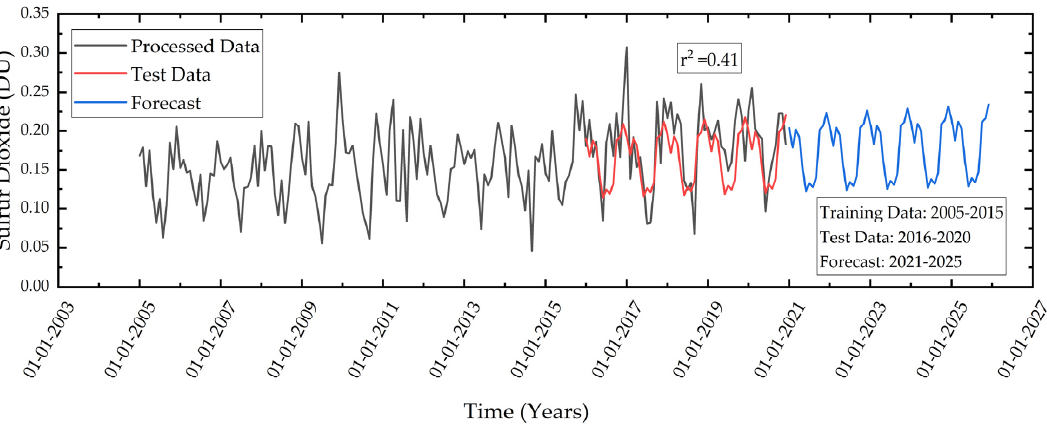
Figure 7. Temporal variations of monthly mean SO 2 in the study area during 2005–2020 and forecast during 2021–2022 using linear regression.